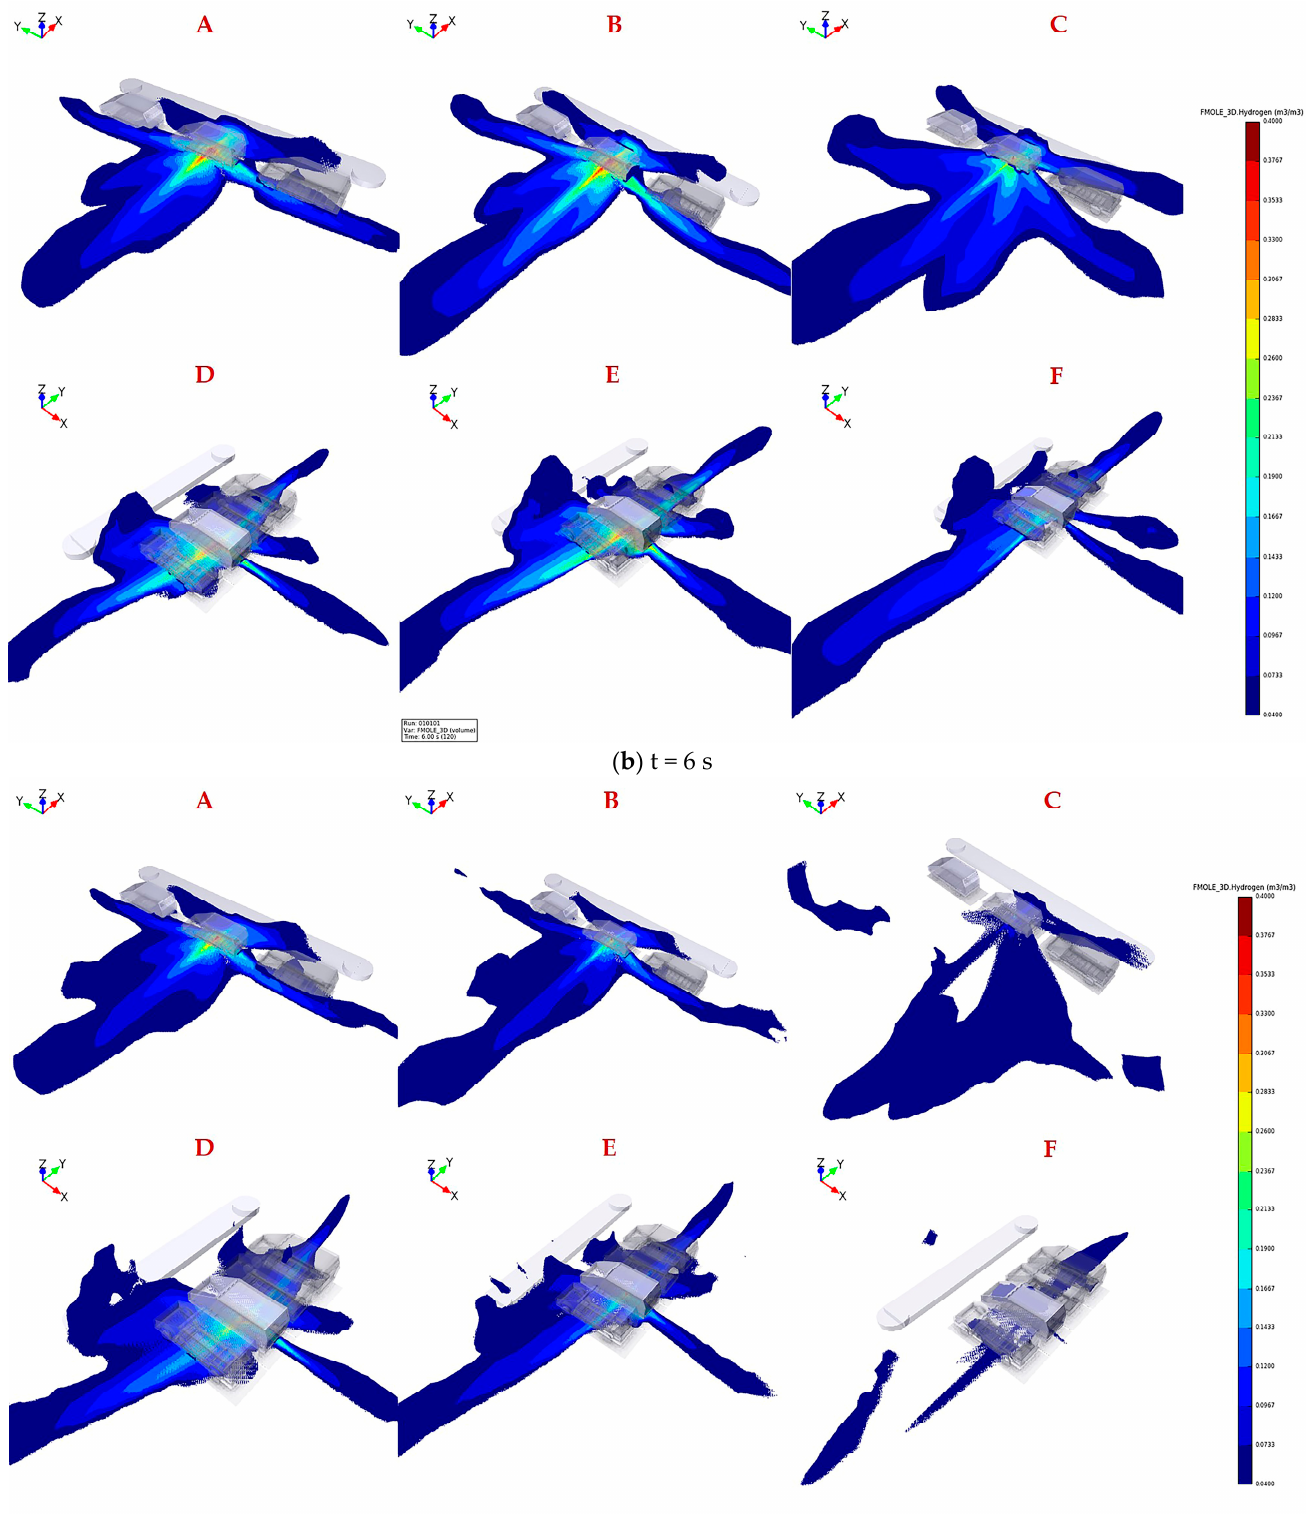
Figure 4. Hydrogen mole fraction between 0.04 and 0.4 by volume for downward releases from 700 bar through 2 mm, 3 mm, and 4mm in parallel ( A – C ) and vertical ( D – F ) parkingconfiguration after 2 s, 6 s, 10 s leakage.